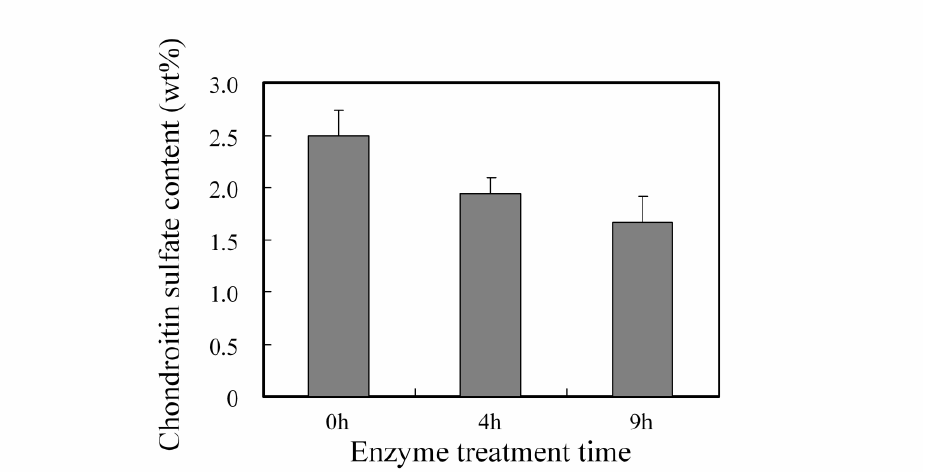
Fig. 8 Changes in chondroitin sulfate content in collagenase-digested articular cartilage before (0 h), after 4 hours (4 h), and after 9 hours (9 h) of collagenase digestion. Mean values (SD) are shown for the 0 h